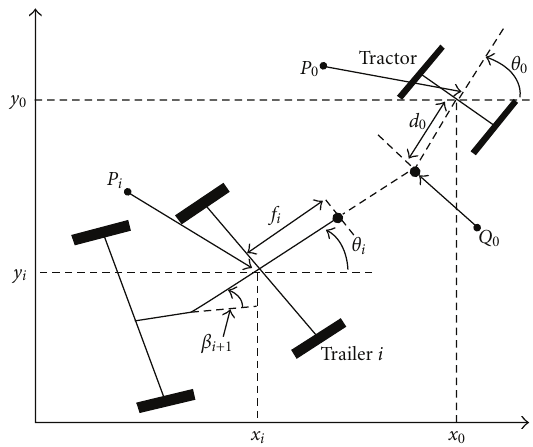
Figure 1: A tractor towing n trailer with o ff -axle